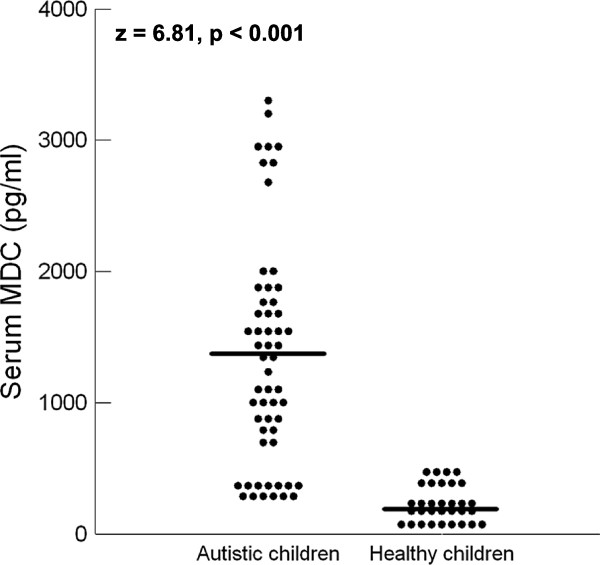
Serum levels of MDC in autistic patients and healthy controls. MDC, macrophage-derived chemokine. Horizontal bars indicate the median values.